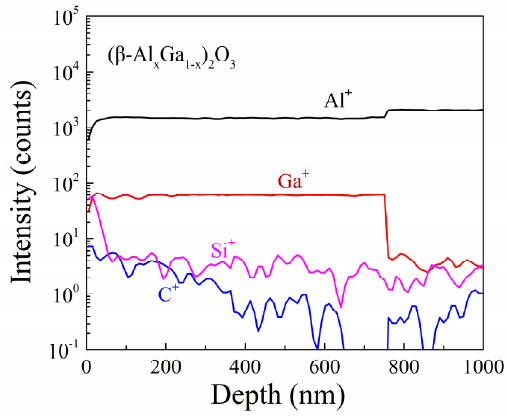
Figure 7. The TOF-SIMS depth profile of β -(Al x Ga 1 − x ) 2 O 3 film. High-resolution field emission transmission electron microscopy (HRTEM, JEM F200) was used to investigate the interface microstructure of β -(Al x Ga 1 − x ) 2 O 3 /Al 2 O 3 0.456 nm, corresponding to the (-201) crystal plane spacing. The transition layer thickness